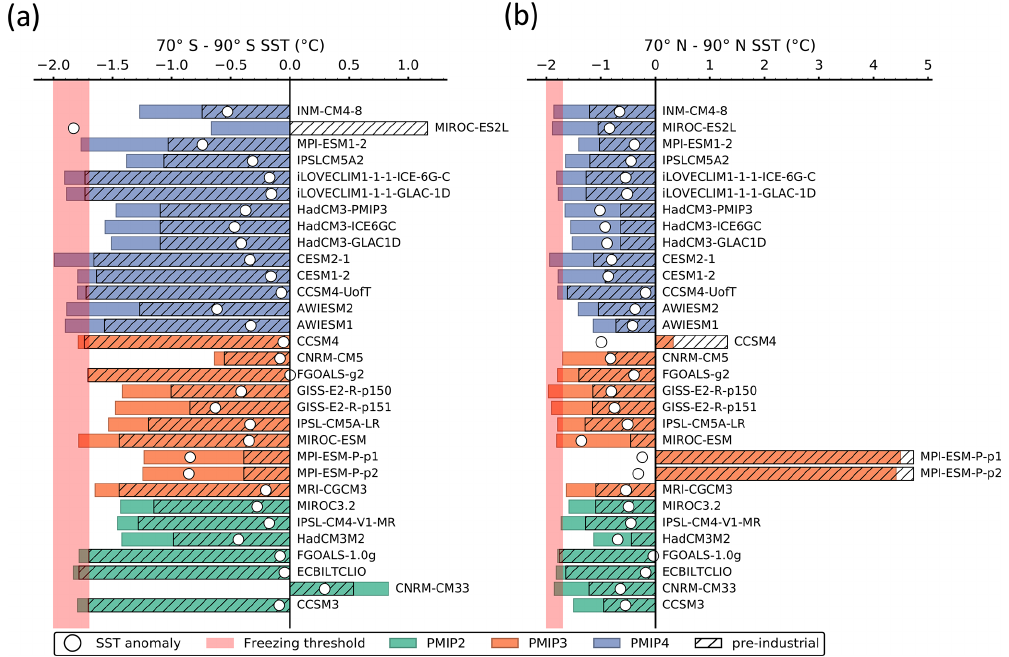
Figure 5. SST ( ◦ C) of the regions (a) south of 70 ◦ S and (b) north of 70 ◦ N in PMIP2, PMIP3 and PMIP4 models in LGM (colored) and pre-industrial (hatched) simulations as well as SST anomaly between the LGM and the pre-industrial period (white dot). The red area bounds the − 1 . 7 to − 2 . 0 ◦ C range for the freezing point of seawater, which varies among models.